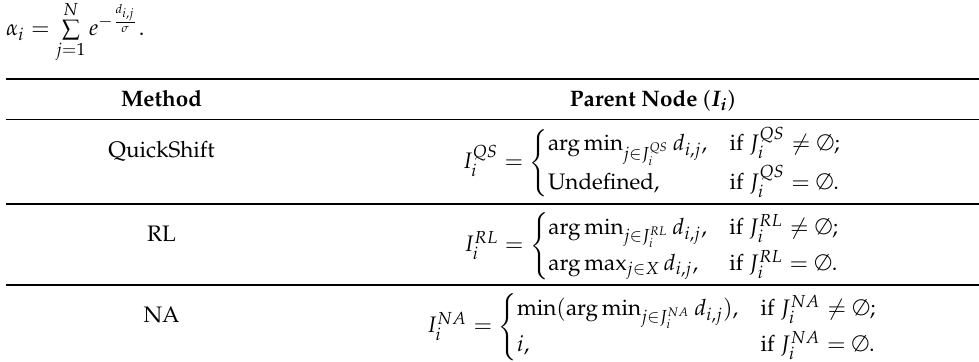
Table 2. Comparison between QuickShift, RL’s method, and NA on the definition for the parent node I i . J QS